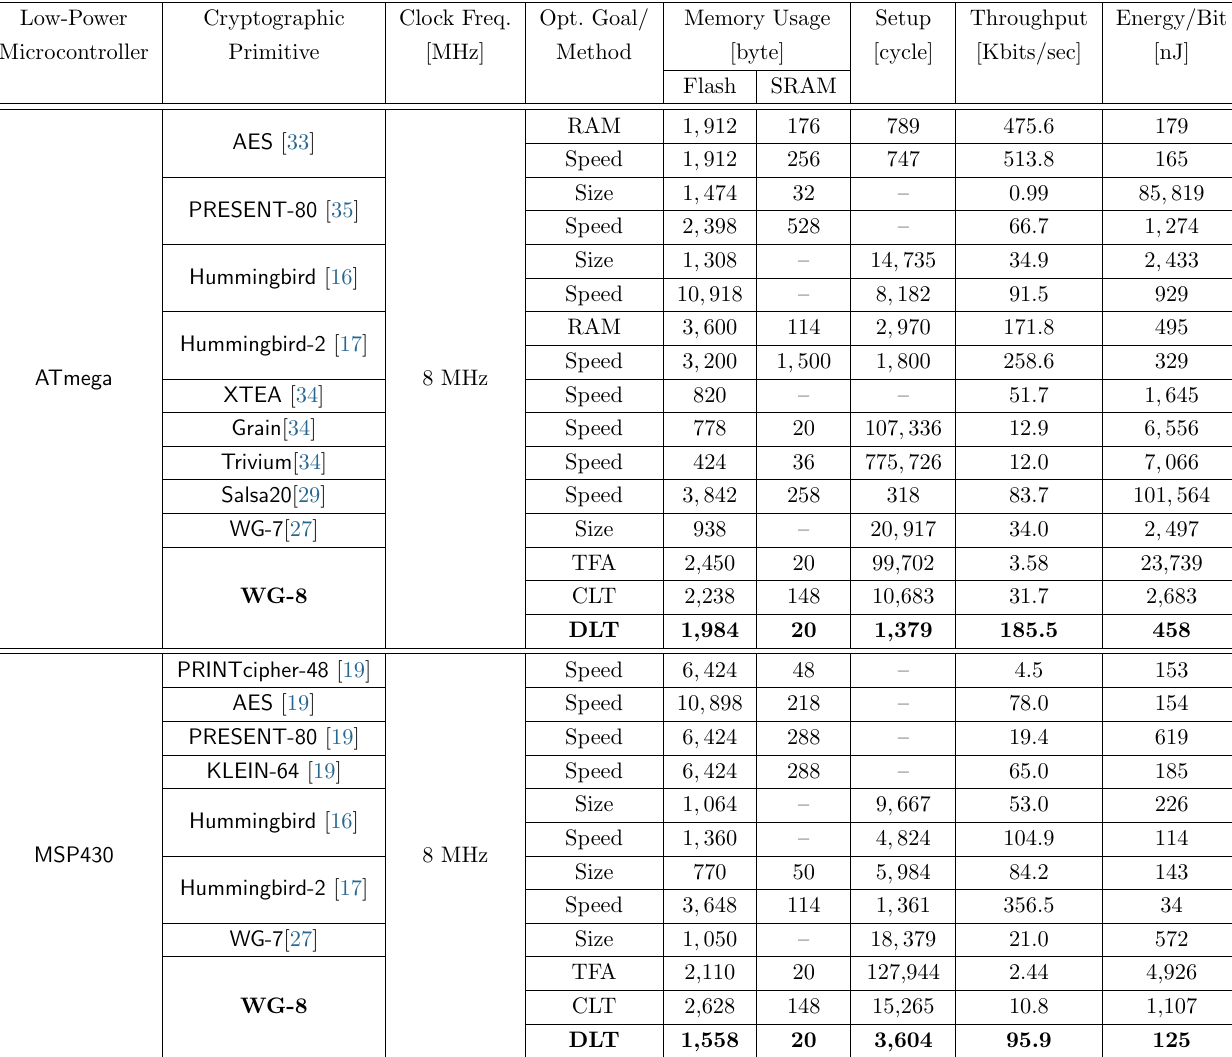
Table 3. Performance Comparison of Lightweight-Cryptography Implementations on Low-Power Microcontrollers Low-Power Cryptographic Clock Freq. Opt.